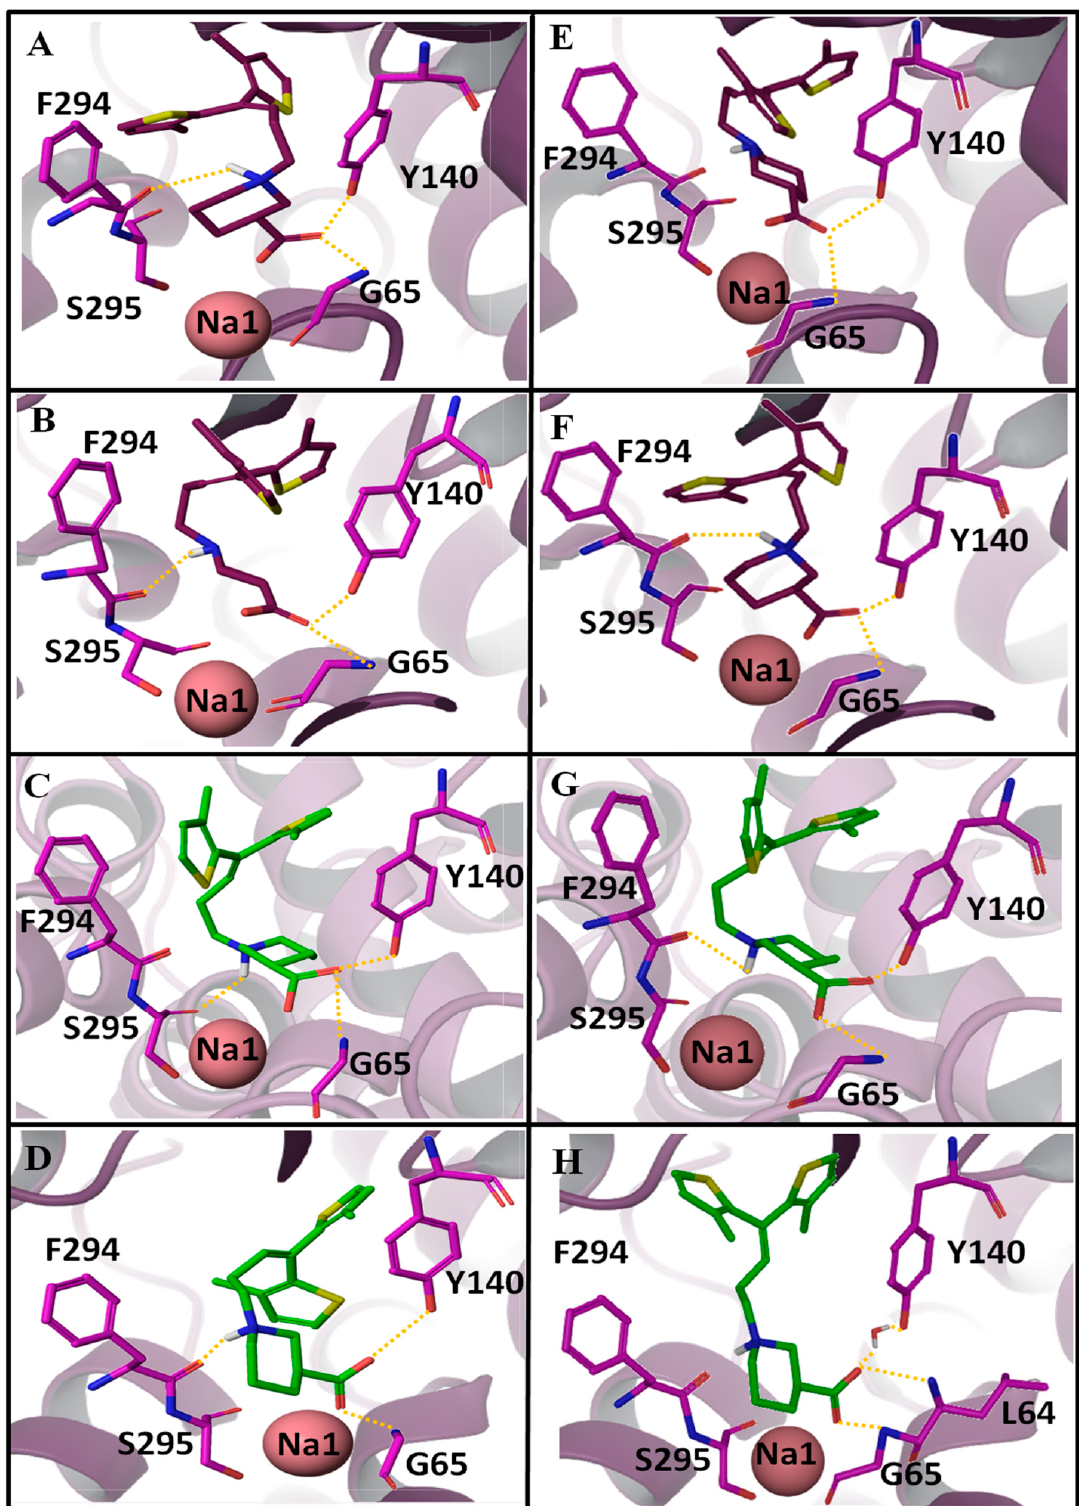
Figure 6. Comparison of ligand-protein interactions in the selected tiagabine enantiomers (Table 1, entries 3, 4, 6, 9). ( A – D ) Interaction pattern of entries 3, 4, 6, 9 in the hGAT1 binding pocket embedded in complete membrane-aqueous system at 0 ns and ( E – H ) after 100 ns of MD.